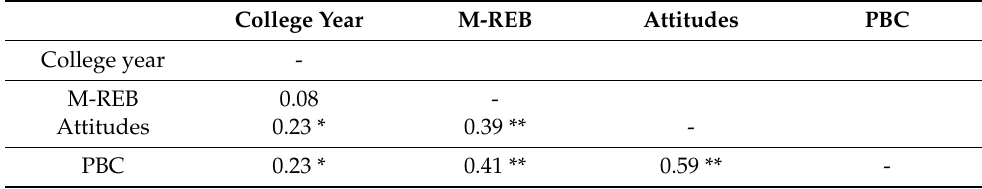
Table 4. Correlation of variables.